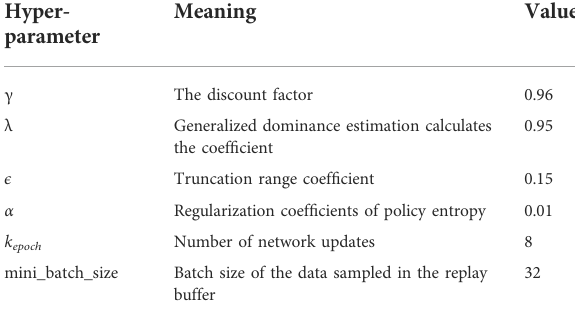
TABLE 10 Settings of the hyperparameters of the PPO